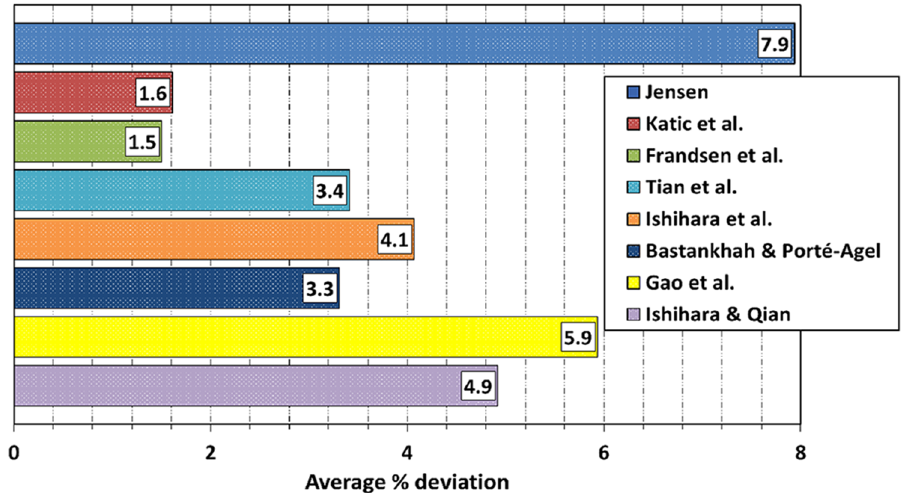
Fig. 12. Average percentage deviation of each wake model in the entire far-wake region for upstream wind speed value equal to 17 m/s.